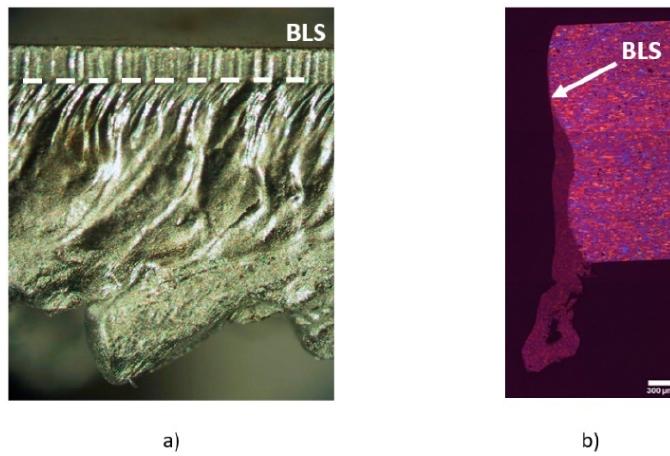
Figure 11. Two regions in the ( a ) cutting edge and in ( b ) the cross section are observed after the boundary layer separation (BLS) during laser cutting of an aluminum-copper alloy, and using a conical nozzle. Reprinted with permission from [30]; Copyright 2010